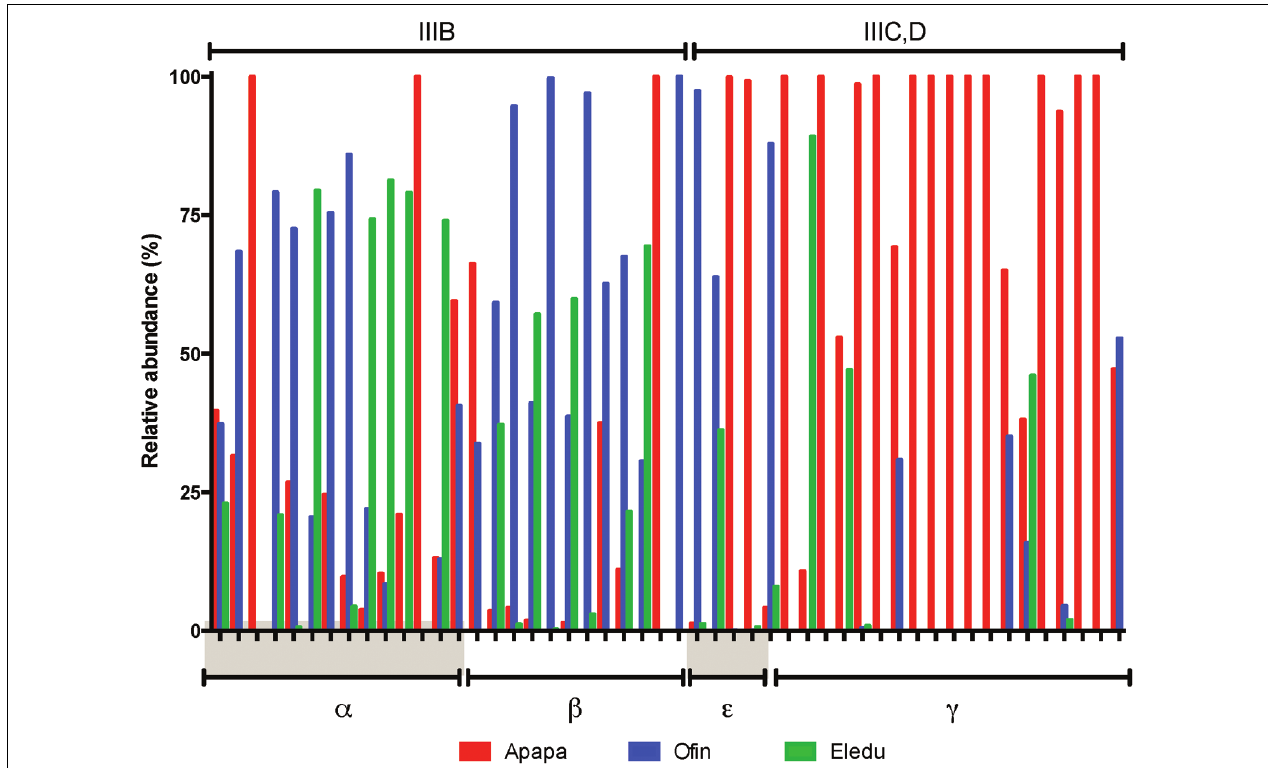
FIGURE 9 | Expanded view of proteobacterial OTU showing significant correlations in abundance to PAH/metals of subcluster III (see Figures 7 and 8A,B). Bars show the relative abundance of each OTU in the indicated sediment, expressed as percentage of the total abundance of the OTU across all samples. Proteobacterial subclasses illustrated are α , alpha; β , beta; γ , gamma, and ε , epsilon. Abundance of each OTU in each sediment is in each of the sediments indicated by bar color (Apapa, red; Ofin, blue; Eledu, green) and expressed as a percentage of the total number of quality-filtered amplicons assigned to that OTU across all